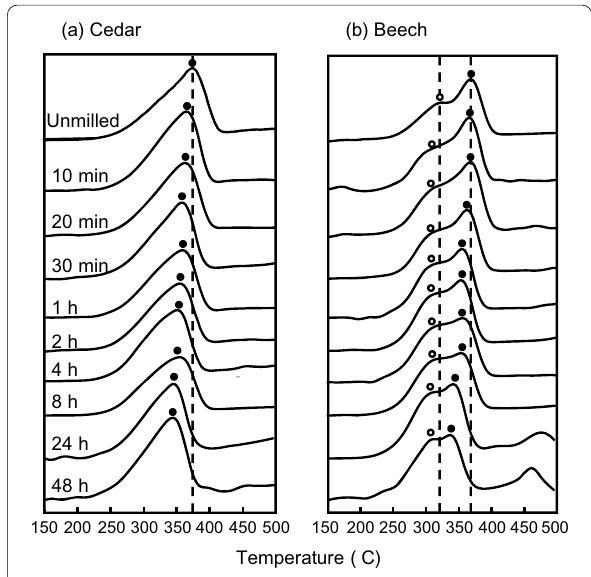
Fig. 5 Influence of milling time on the DTG curves of ball-milled a cedar and b beech